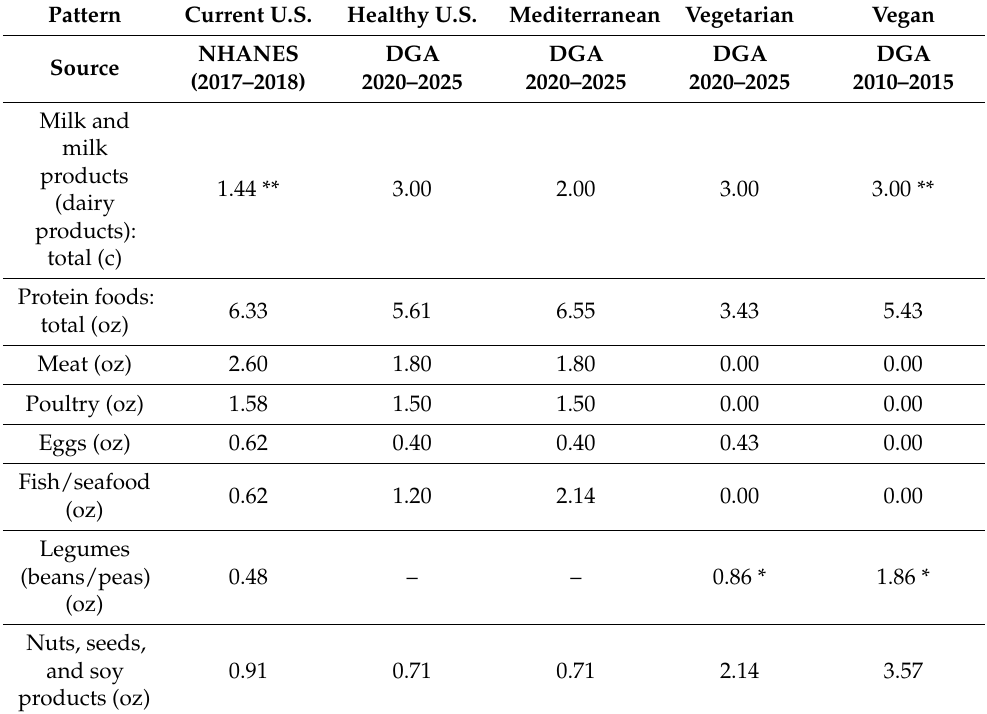
Table 1. Cont. Pattern Current U.S. Healthy U.S. Mediterranean Vegetarian